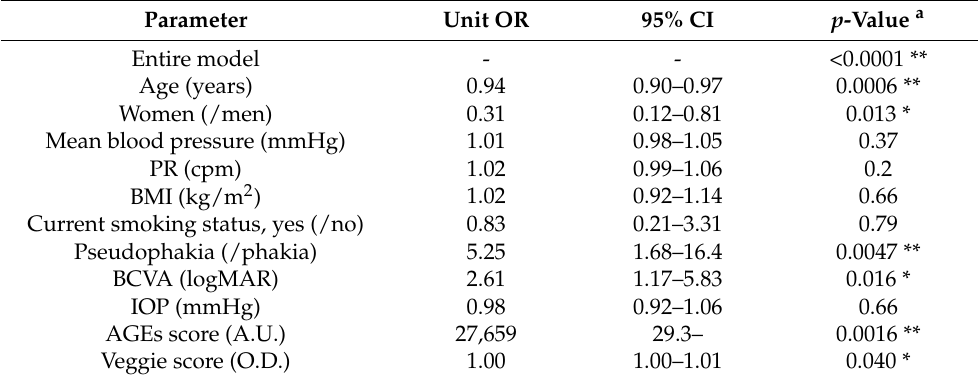
Table 3. Multivariate logistic regression analysis for risk factors for DR.